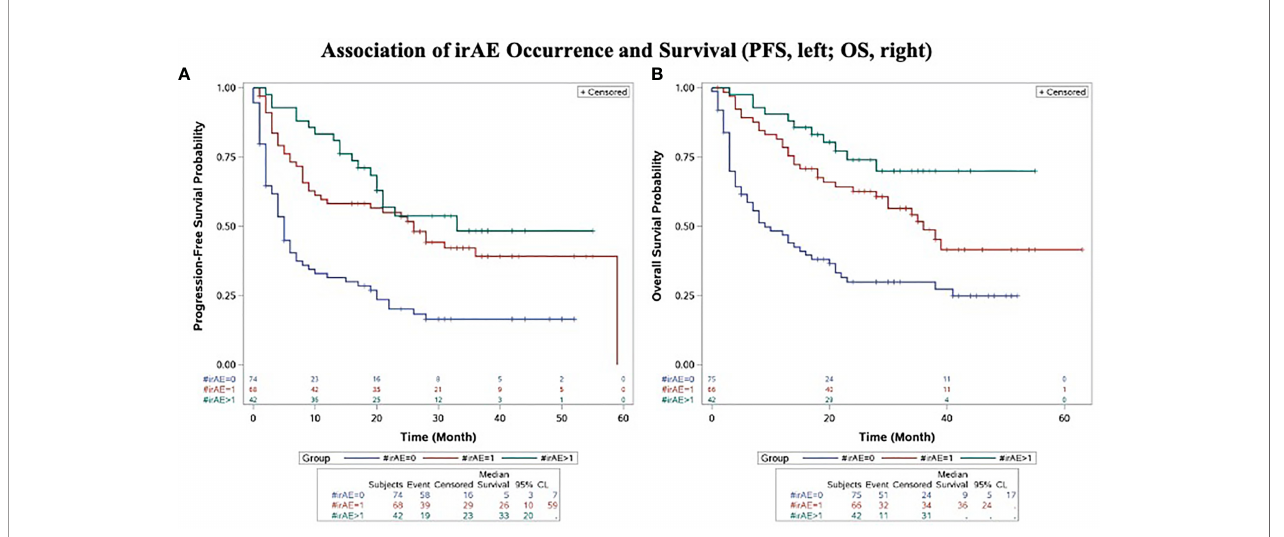
FIGURE 4 | Association of irAE Occurrence and Progression-Free Survival (A) and Overall Survival (B) . Kaplan-Meier plots of progression-free survival (A) and overall survival (B) in advanced melanoma patients treated with anti-PD-1 therapy compared by development and extent of irAE (0 vs . single vs . multiple). All p-values signi fi cant and unadjusted for multiple